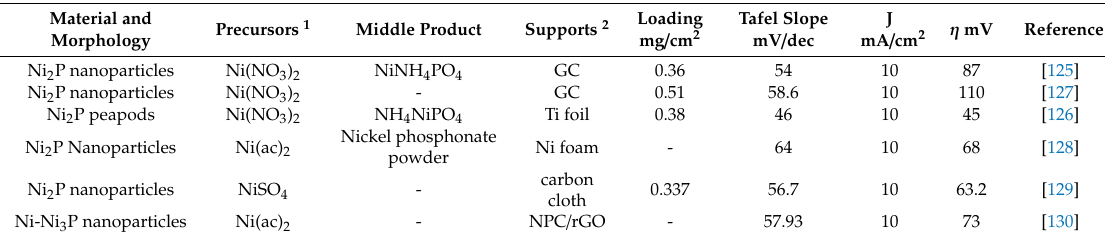
Table 7. Summary of the nickel phosphide electrocatalysts prepared through hydrogen reduction of phosphates for HER in acidic